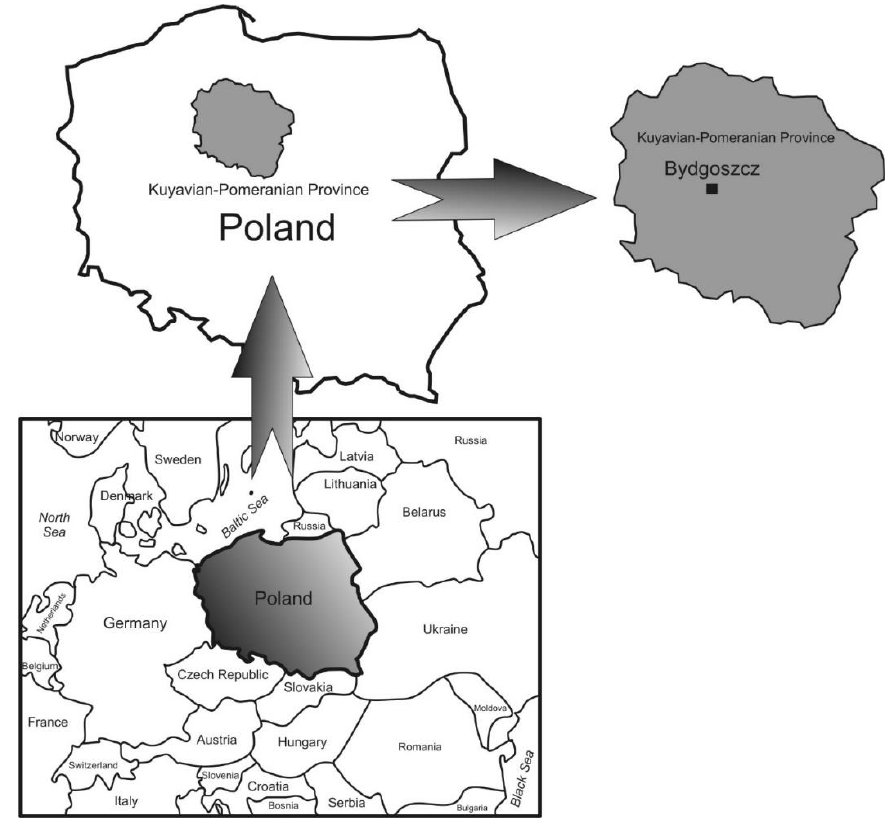
Figure 1. Location of the Bydgoszcz region—within the Kuyavian-Pomeranian Province—in Poland and in Europe.